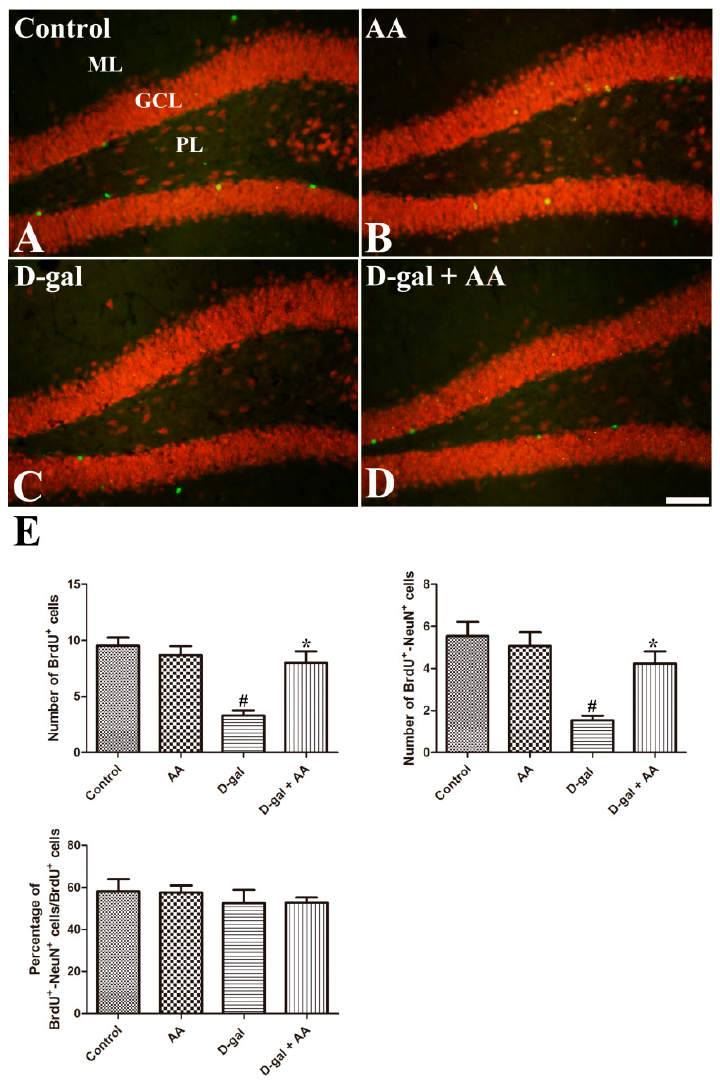
Figure 4. Double immunofluorescence staining of BrdU (green) and NeuN (red) in the dentate gyrus in control ( A ), ascorbic acid (AA) ( B ), D-galactose (D-gal) ( C ), and ascorbic acid (150 mg / kg)-fed D-gal ( D ) groups. Note that D-gal-induced reduction in the number of BrdU-incorporated cells (BrdU + ) is significantly attenuated by ascorbic acid administration in the D-gal + AA group. The changes in the number of BrdU + -NeuN + cells show the same pattern as those of BrdU + cells. GCL, granule cell layer; ML, molecular layer; PL, polymorphic layer. Scale bar = 50 µ m. ( E ): The numbers of the BrdU + and BrdU + -NeuN + cells in the dentate gyrus of the hippocampus. The percentage of BrdU + -NeuN + cells out of the total number of BrdU + cells did not change ( n = 10 per group; # p < 0.05, indicating a significant difference between control and D-gal groups; * p < 0.05, indicating a significant difference between D-gal and D-gal + AA groups). Data are presented as means ± SEM.